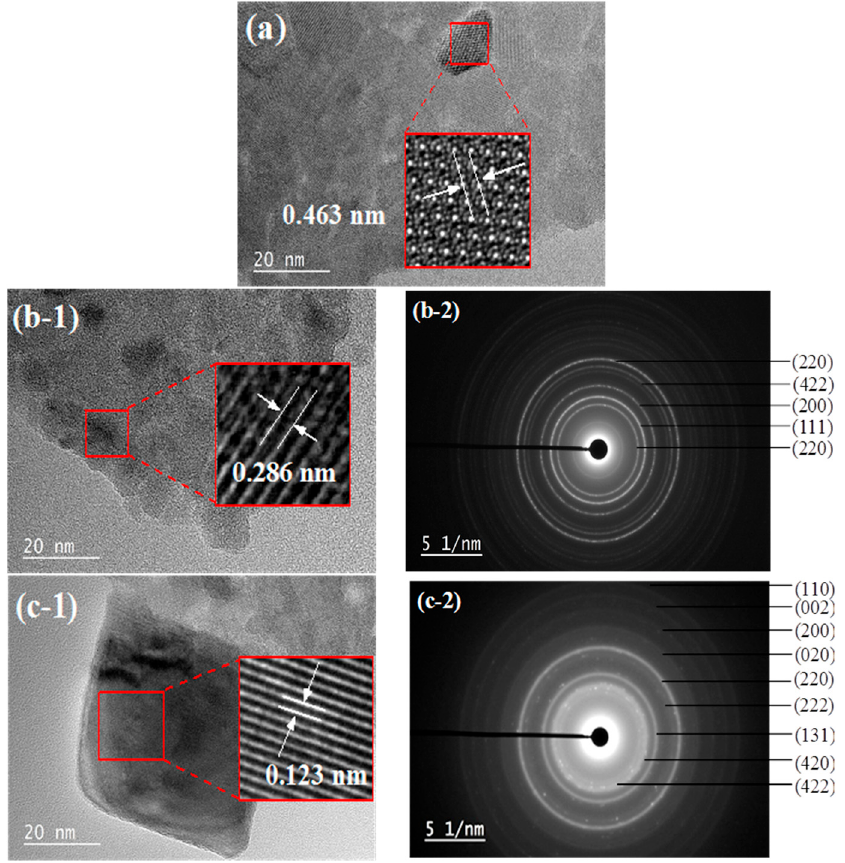
Figure 7. Lattice fringes and Selected Area Electron Diffraction (SAED) patterns of ( a ) 10Ni–Al, ( b ) 10Co–Al and ( c ) 10Cu–Al calcined samples. Materials 2019 , 12 , x FOR PEER REVIEW